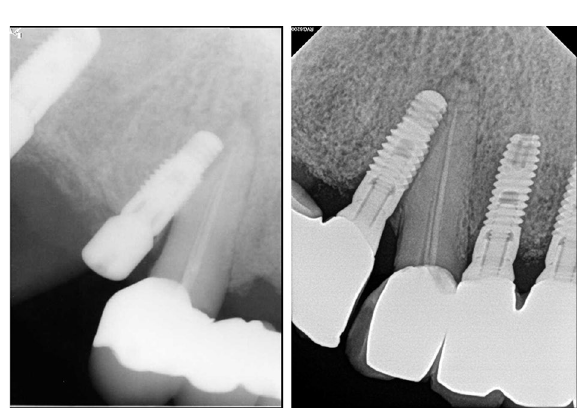
Figure 1. Direct invasion of the endodontic treated adjacent tooth by an implant. (Left) At the time of implant surgery, June 2012; (right) at 8 years after injury, August 2020.